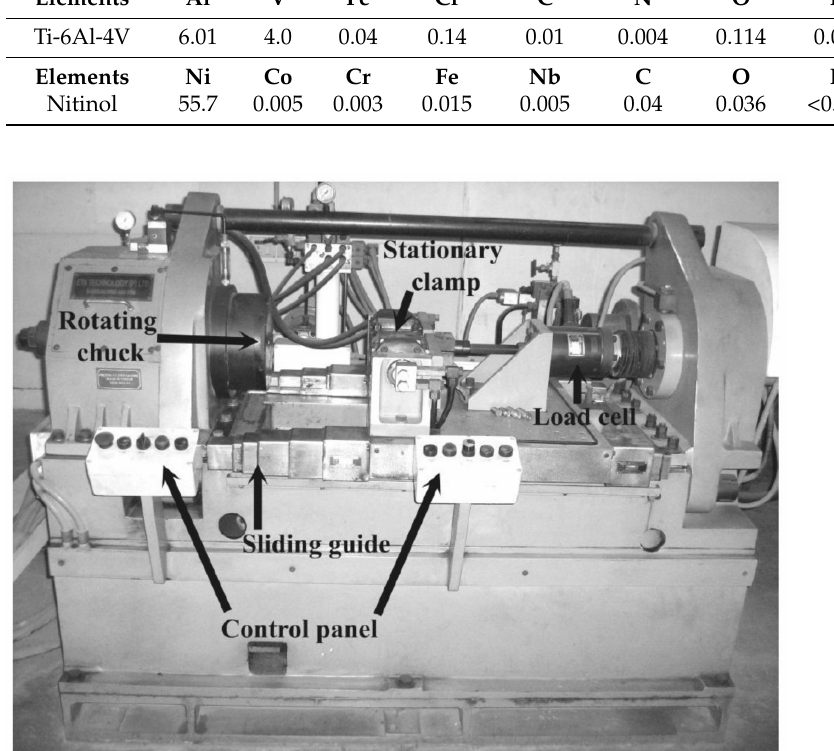
Figure 1. Friction welding machine used in the current